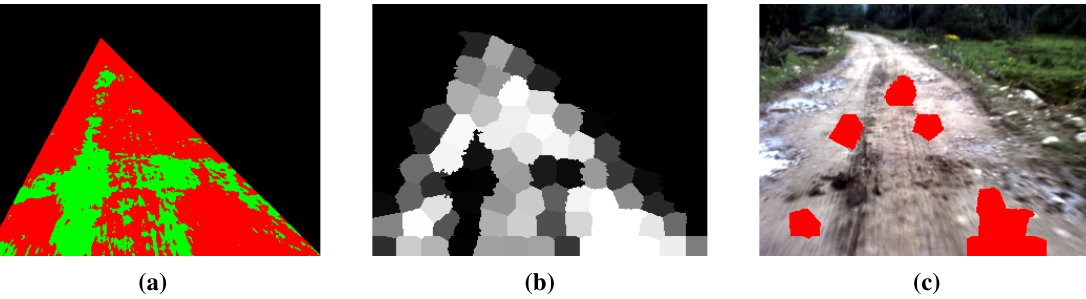
Figure 8. Illustration of superpixel-level road seed selection: ( a ) the result of road region clustering; ( b ) the probability of being road seeds (the brighter the superpixel, the higher the probability); ( c ) the result of superpixel-level road seed